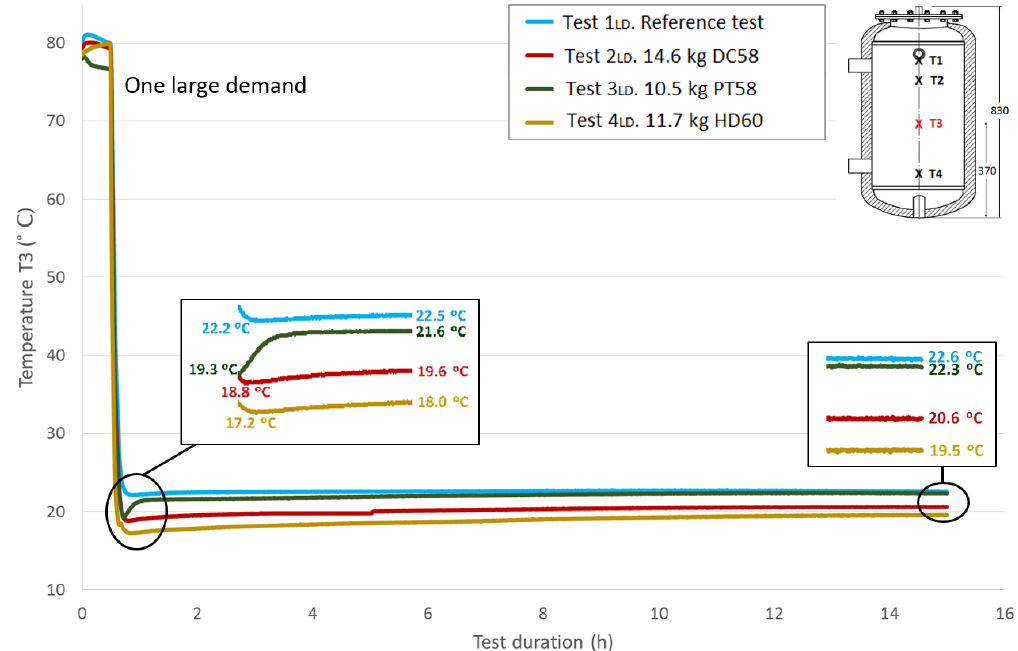
Figure 10. Medium bottom height water temperature ( T 3) inside the tank during the one large demand experiment. (dimensions are in mm).